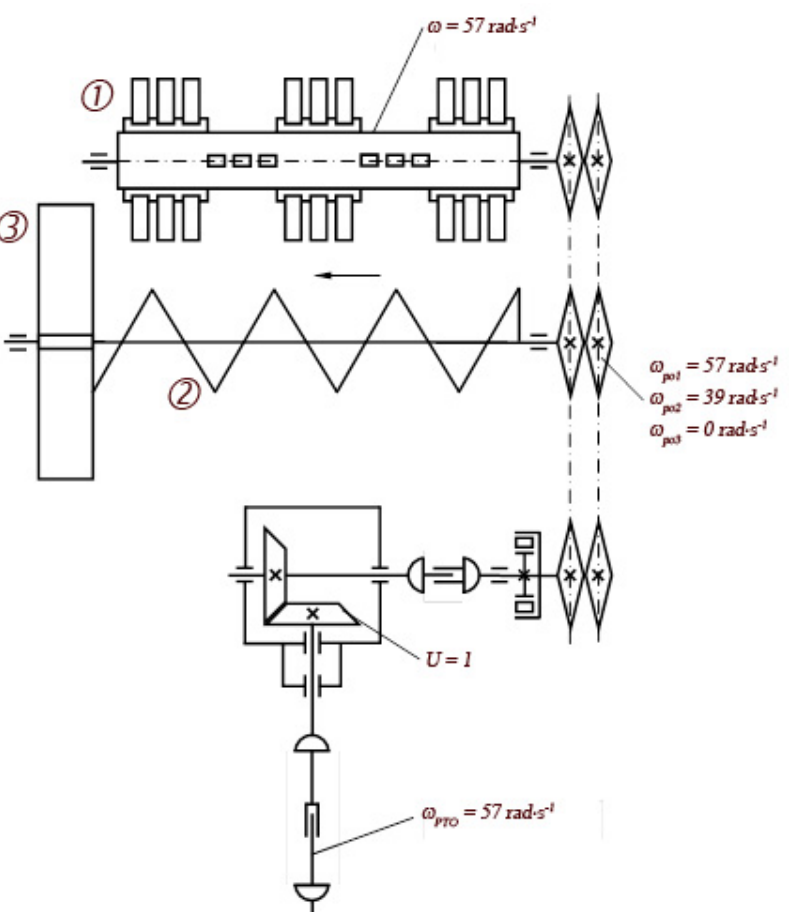
Figure 4. Kinematic diagram of the tested three row beet top harvester: 1—rotary beet top cutting device, 2—screw conveyor, 3—loading chute feeder.